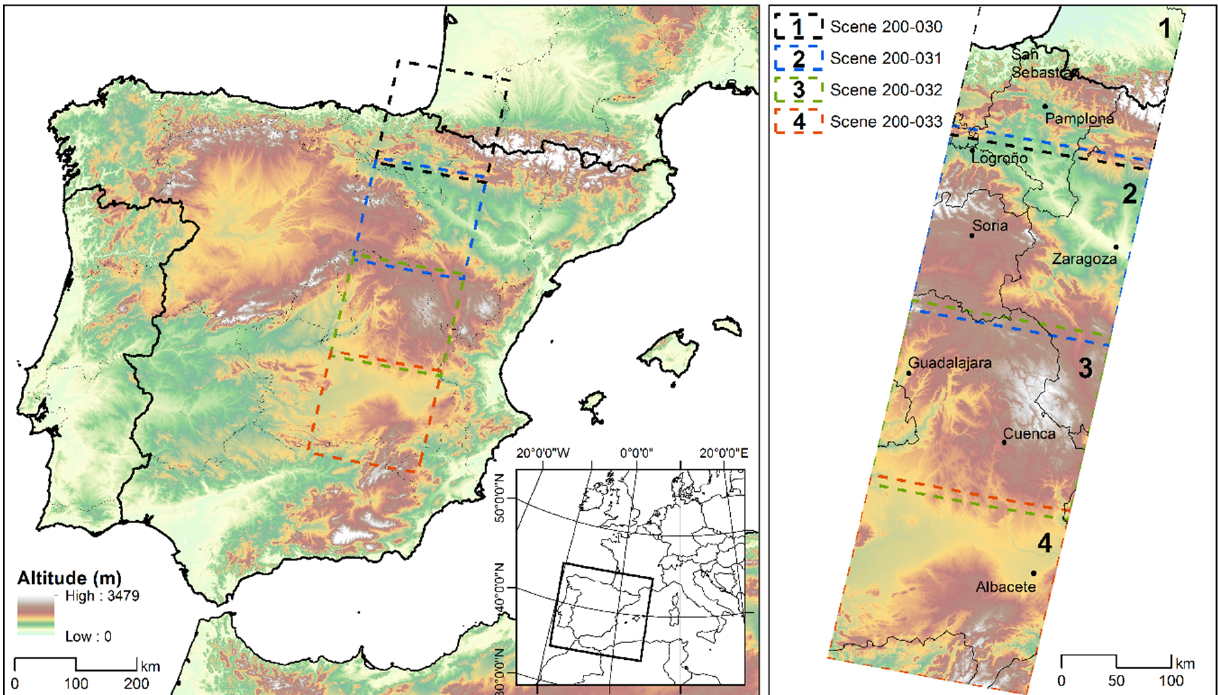
Figure 1. The spatial location of the Landsat scenes in the context of the Iberian Peninsula.